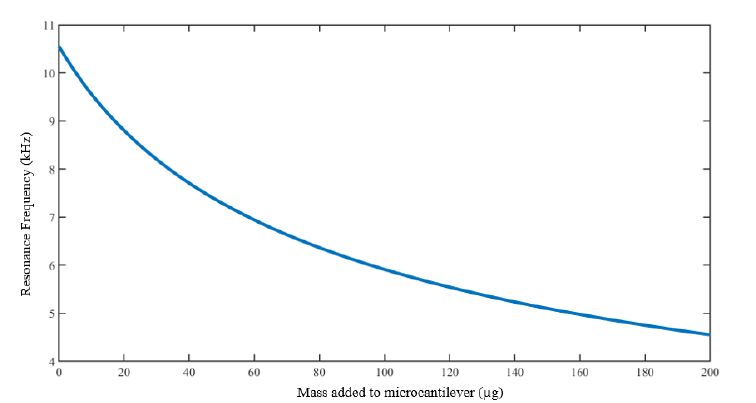
Figure 5. Simulated polynomial-like microcantilever resonance frequency response to the mass added, for the modeled piezoelectrically driven microcantilever